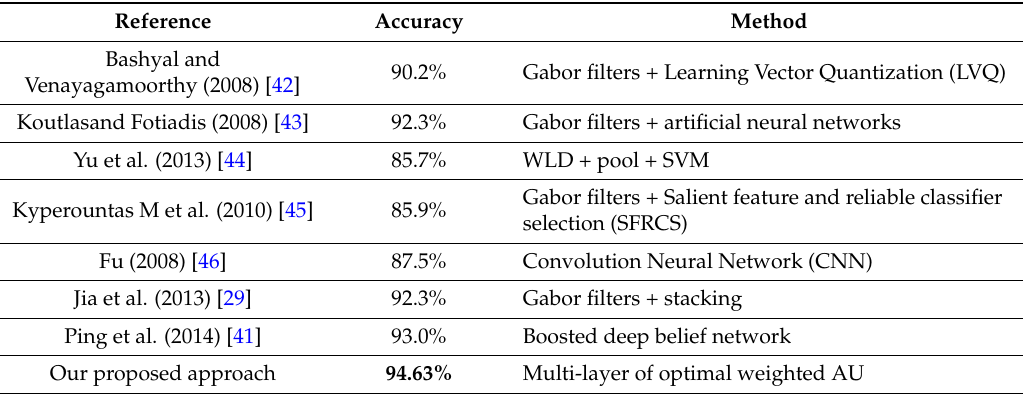
Table 12. Comparison with existing methods on JAFFE